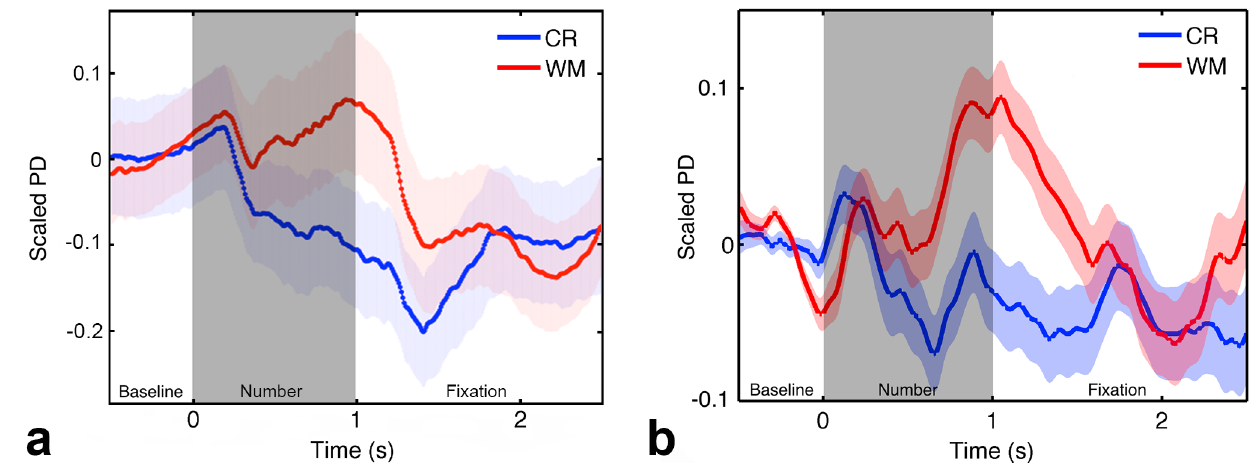
Figure 3. Pupil dilation patterns in response to information differ as a function of attention. (A) Pupils exhibited task-evoked dilations to stimuli only when they were task-relevant, F (2.841, 42.621)=5.818, p , .002. Error bars indicate one standard error of the mean. Given controlled luminance across conditions, we attribute this coupling to the information carried by the stimulus, and not to changes in low-level luminance. (B) Smallwood and colleagues’ findings (adapted from [25]) for comparison.